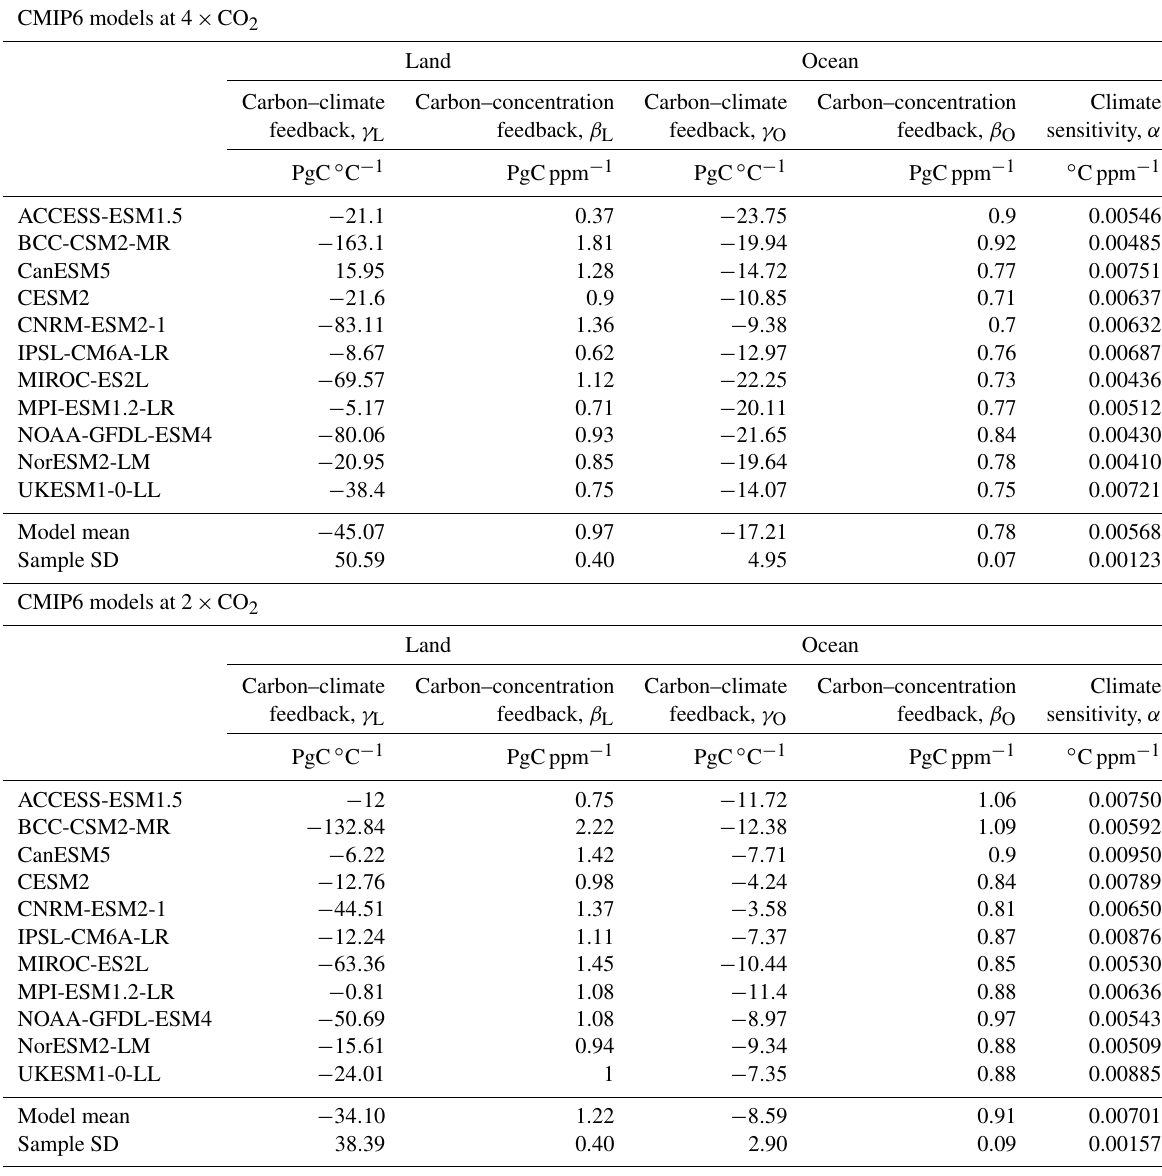
Table A1. Values of carbon–concentration and carbon–climate feedback parameters for land and ocean calculated using the BGC–COU approach (using results from the BGC and COU simulations) and the linear transient climate sensitivity to CO 2 , from CMIP6 and CMIP5 models at 4 × CO 2 (i.e. at the end of the 1pctCO2 simulation) and 2 × CO 2 . CMIP6 models at 4 × CO